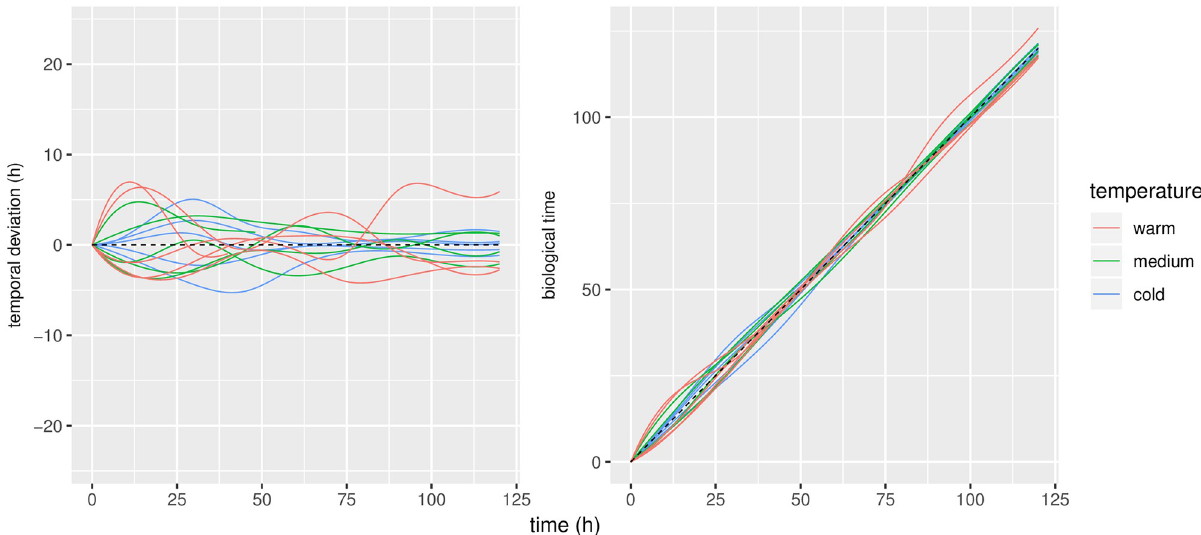
Fig 5. Predicted warp functions. Left panel: deviations from the identity. Right panel: resulting warping functions. Black line indicates the identity, ie. no temporal deviation.